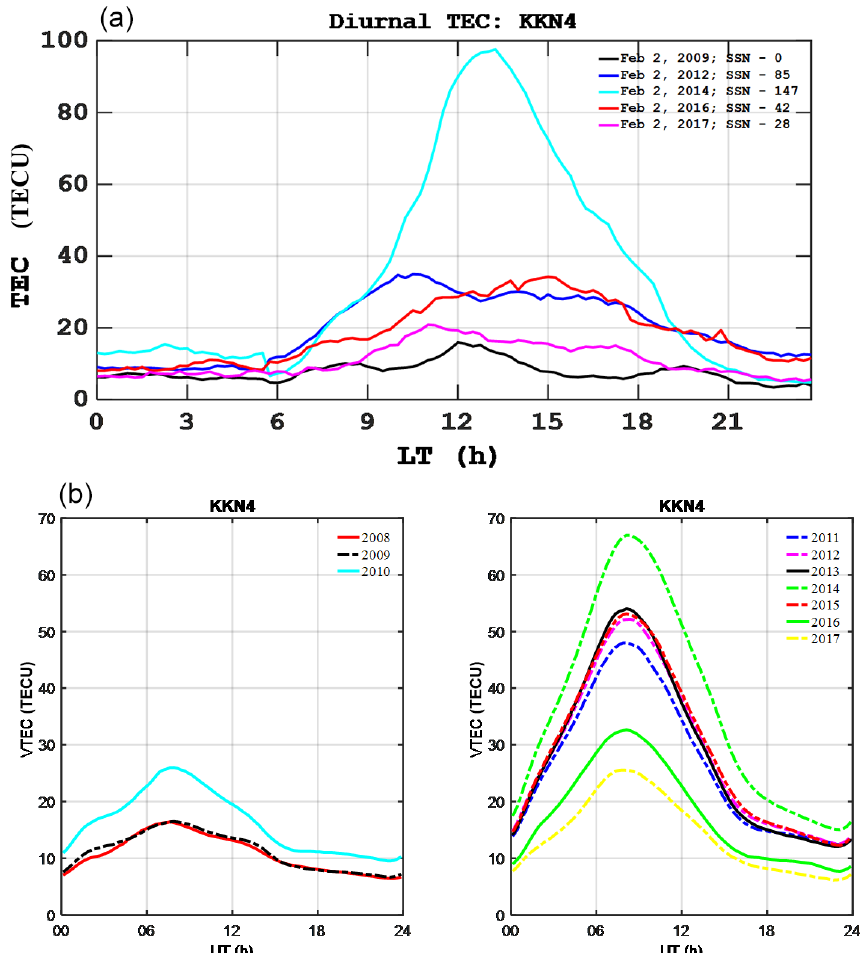
Figure 3. (a) Diurnal variation in vertical TEC at KKN4 GPS station. The black, blue, light green, red and pink colour lines represent the diurnal variation for the years 2009, 2012, 2014, 2016 and 2017. (b) Yearly mean diurnal variation in vertical TEC; the left represents the wave-like nature and the right represents the parabolic